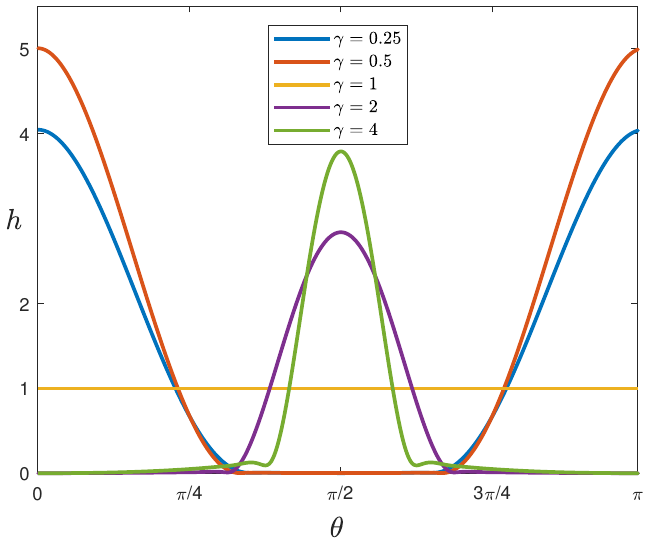
Figure 4. Thickness profiles at t = 5 × 10 4 , for ( Ω d , Bo ) = ( 0,0 ) , where γ = 0.25,0.5,1,2, and 4.